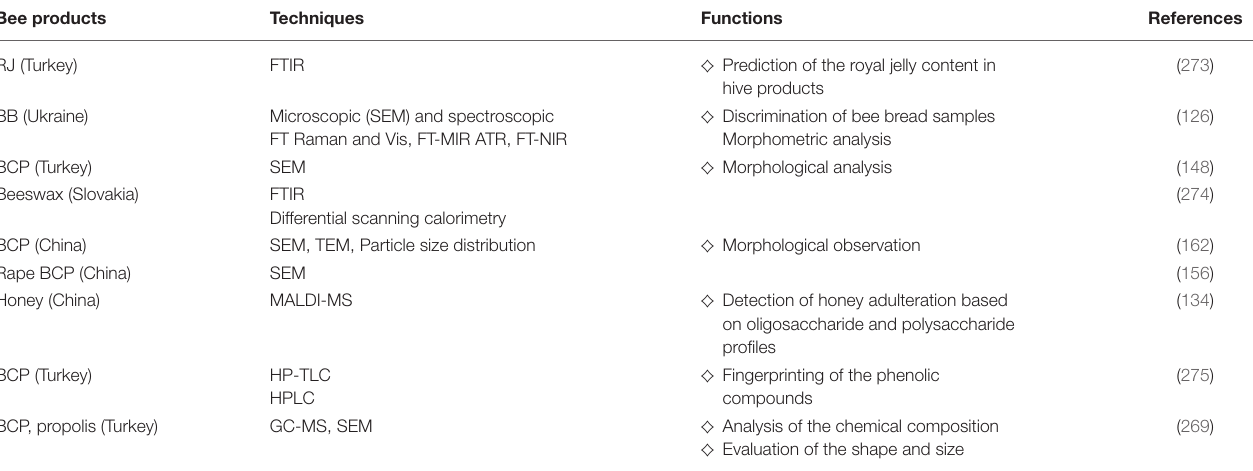
TABLE 7 | Assessment methods for the bee